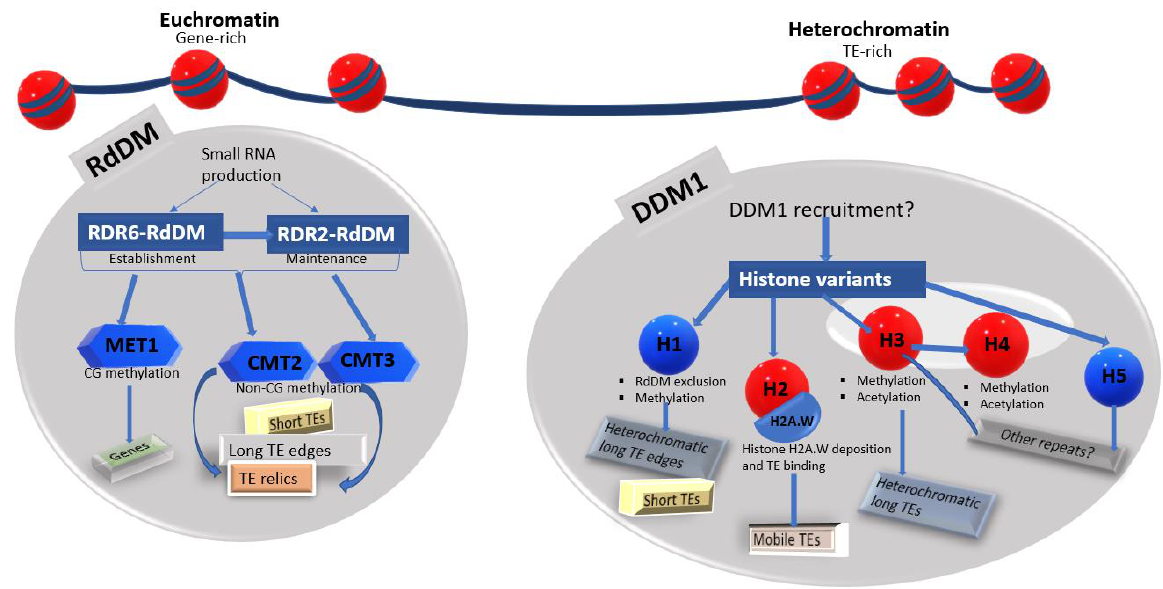
Figure 4. A model for the role of DDM1 in maintaining TE silencing in Arabidopsis thaliana . The chromatin environment shapes the epigenetic landscape for TE silencing. RdDM is predominant in the euchromatin and excluded from the heterochromatin by DDM1 via histone H1 [11,23]. DDM1 is required to maintain the heterochromatin and silence TEs via different histone variants. DDM1- mediated H2A.W deposition exclusively silences mobile TEs [22]. Some immobile TEs are also si- lenced by DDM1 in the heterochromatin [11]. RdDM: RNA-directed DNA methylation, RDR2: RNA-DEPENDENT RNA POLYMERASE2, RDR6: RNA-DEPENDENT RNA POLYMERASE6, MET1: DNA METHYLTRANSFERASE1, CMT2: CHROMOMETHYLASE2, CMT3: CHROMO- METHYLASE3 and TE: Transposable element.